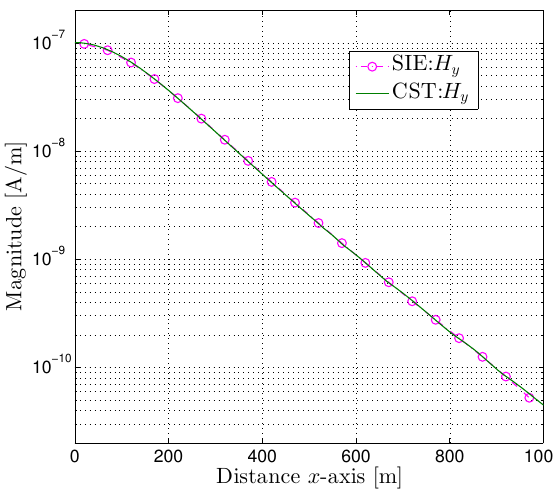
Figure 8. Magnetic field in the y -direction component at test point ( x ,0, − 500 ) . Table 3. Electric field in the x -direction component at test point ( 0, y , − 500 ) .